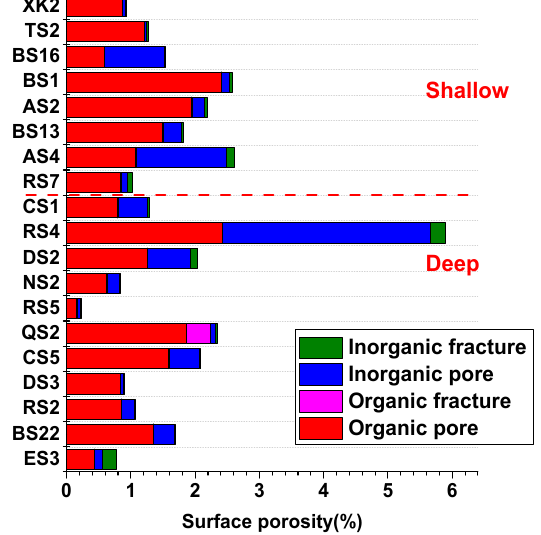
Figure 12. Diagram of pore composition.